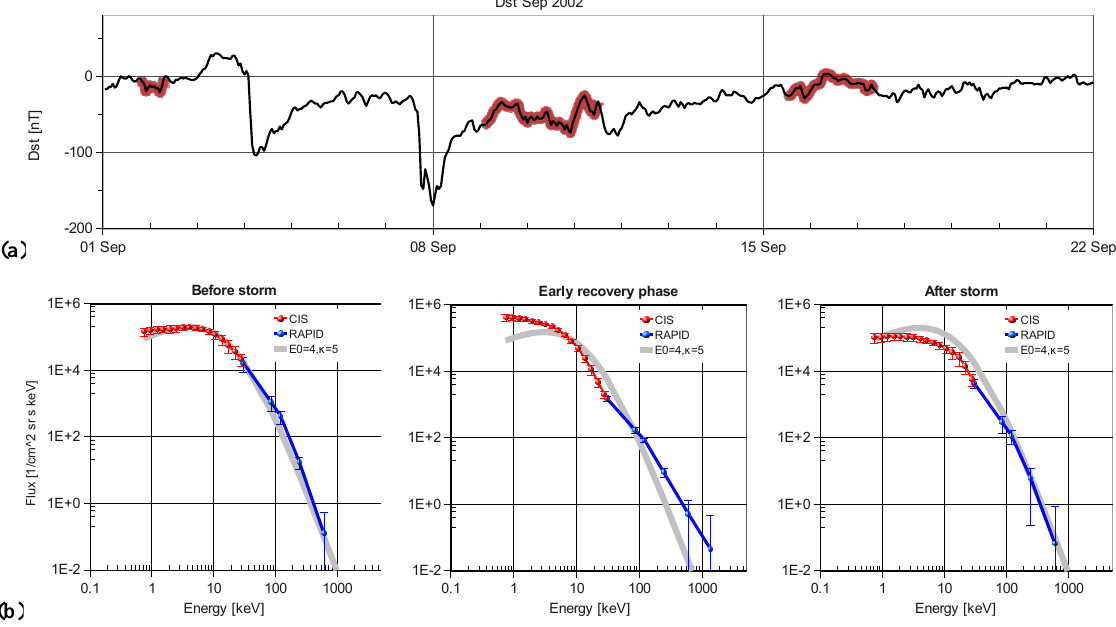
Fig. 4. Same as Fig. 3, but for two geomagnetic storms in September 2002. There were no Cluster observations satisfying our criteria during neither of the main phases of the storms for this case.